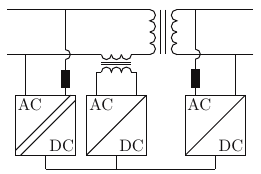
Figure 3. Combined HDT configuration.